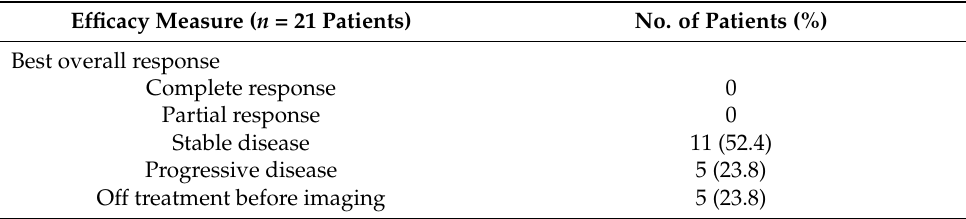
Table 3. RECIST response assessment to lenvatinib